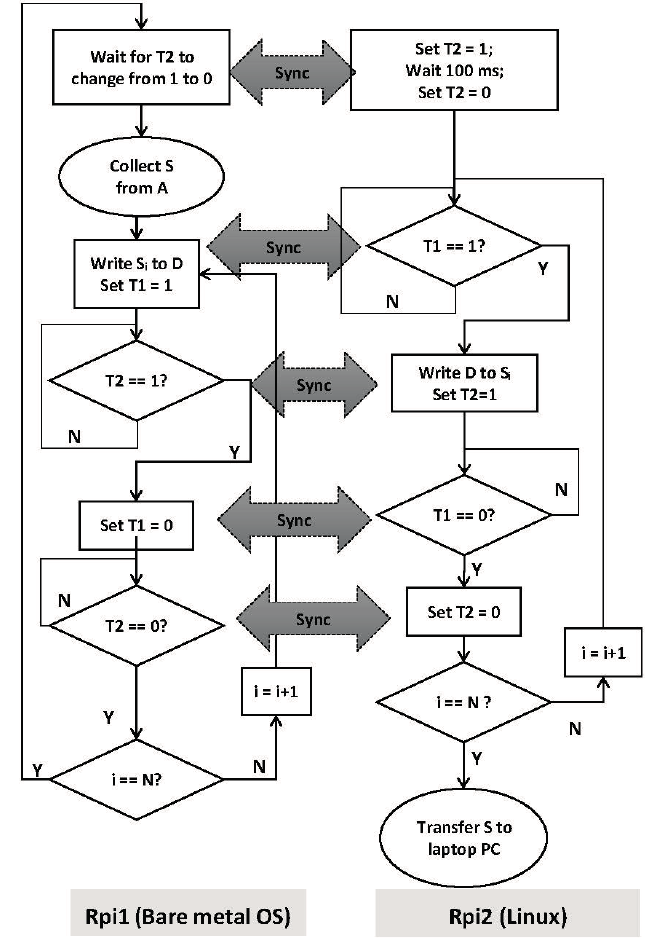
Figure A2. Algorithm for data transfer of the acquired signal S via GPIO between the two Raspberry Pi devices. The signal S has length N. The grey double-arrow boxes indicate the syncing of transfer in the protocol